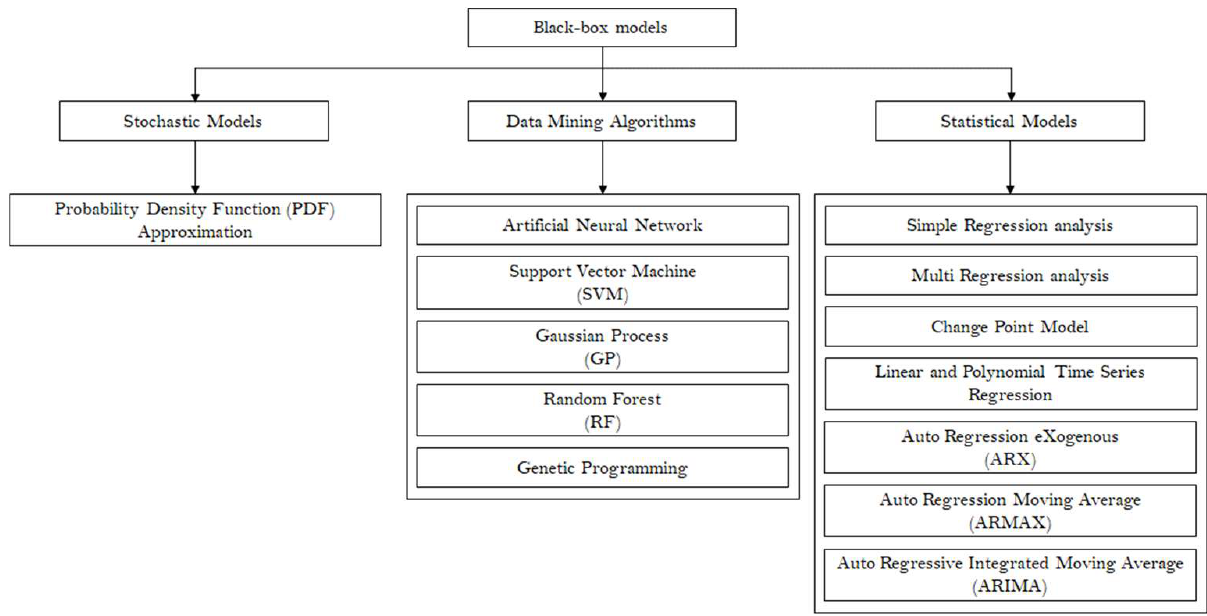
Figure 6. Classification of Black-box Model [30].